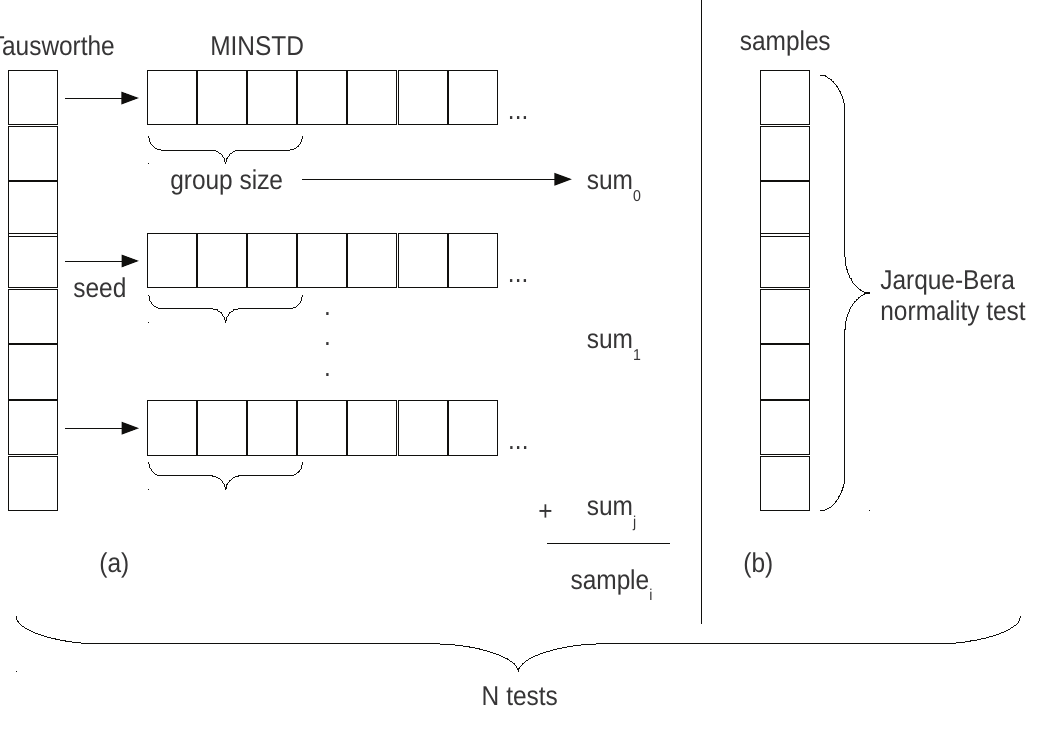
Figure 5: The structure of the block test. (a) Streams of MINSTD generators seeded from a single hybrid Tausworthe generator. Sequential samples for each MINSTD, of group size, are totaled to create a single sum value. This is repeated for each MINSTD stream. The total of the sum values forms a single sample. (b) The collection of samples is given to the Jarque-Bera test for normality as described in the text. The entire process, (a) and (b), is repeated to form N tests, always with a new hybrid Tausworthe generator seeded with the Unix system